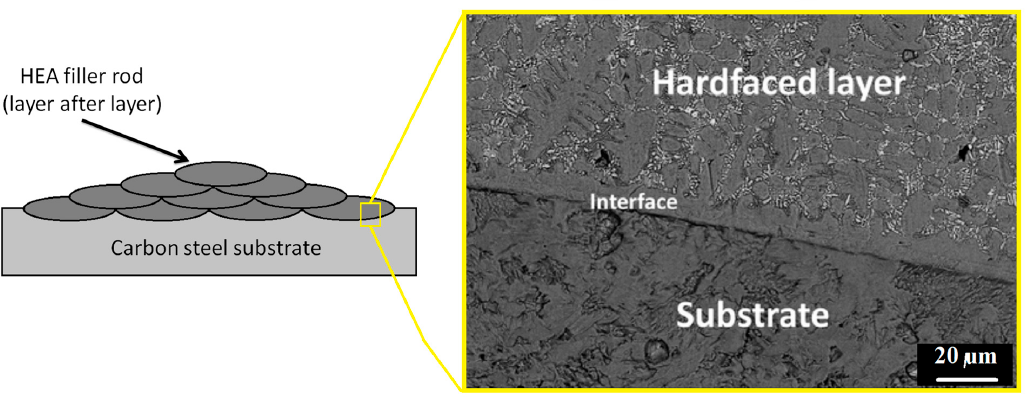
Figure 12. Schematic illustration of the use of HEA welded layer after layer in a carbon steel substrate and inset of the formed interface. Adapted from [37].